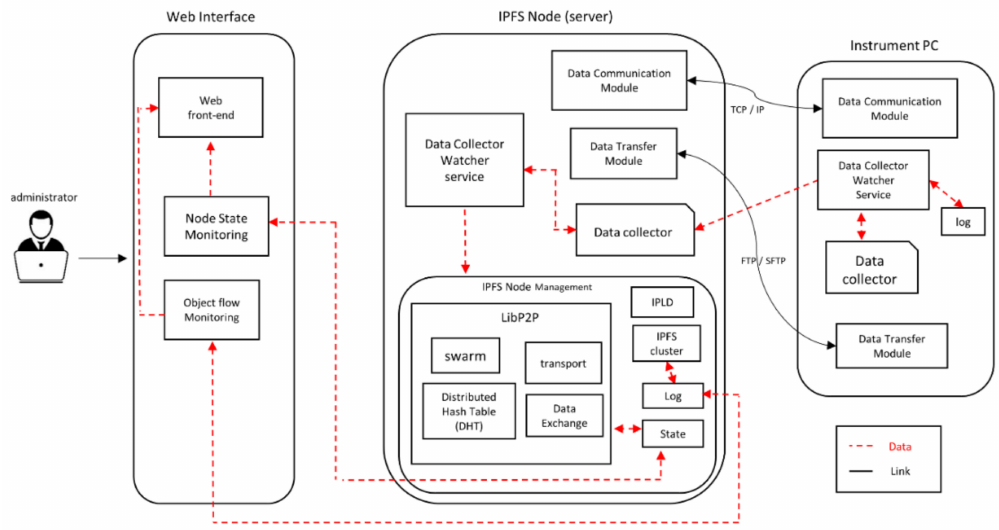
Figure 4. The proposed system